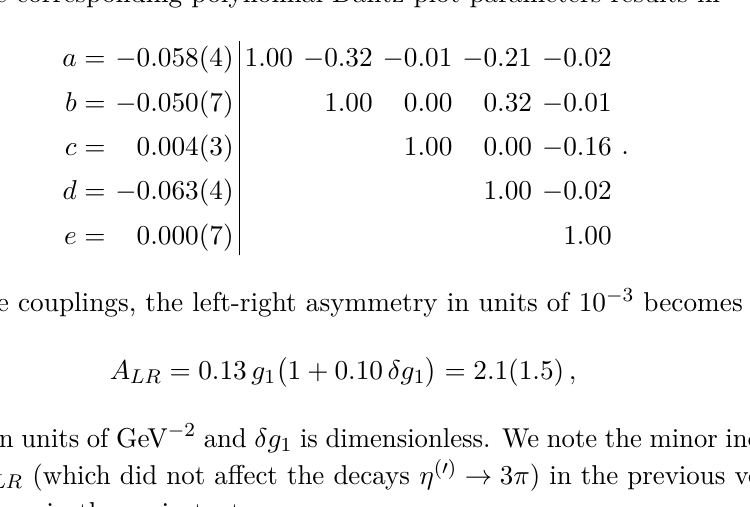
Figure 3 . Dalitz-plot decomposition for η 0 6 C C of (right). This is the corrected version of figure 9 in ref. [1]. 0 and M 1 M